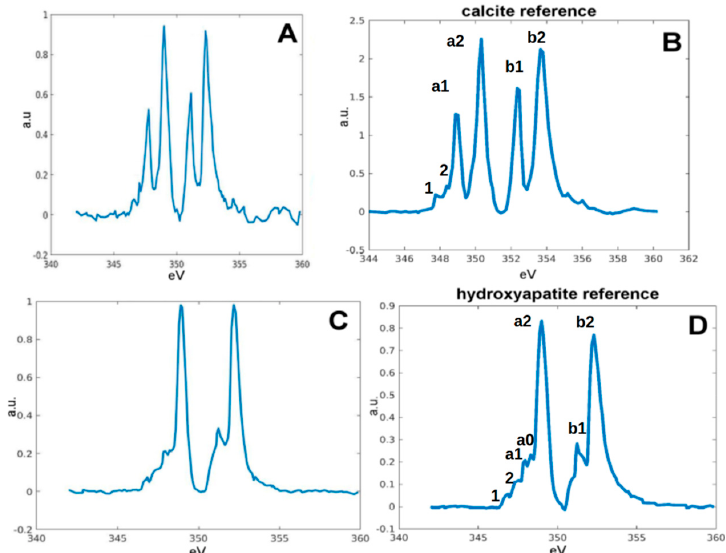
Figure 4. ( a ) Calcite spectra detected in bMSC-4D. ( b ) Characteristic spectrum of calcite measured in a reference standard. ( c ) HA spectra detected in bMSC-10D. ( d ) Characteristic spectrum of HA measured in a reference standard. In ( b , d ), the main spectral features are indicated by letters and numbers.